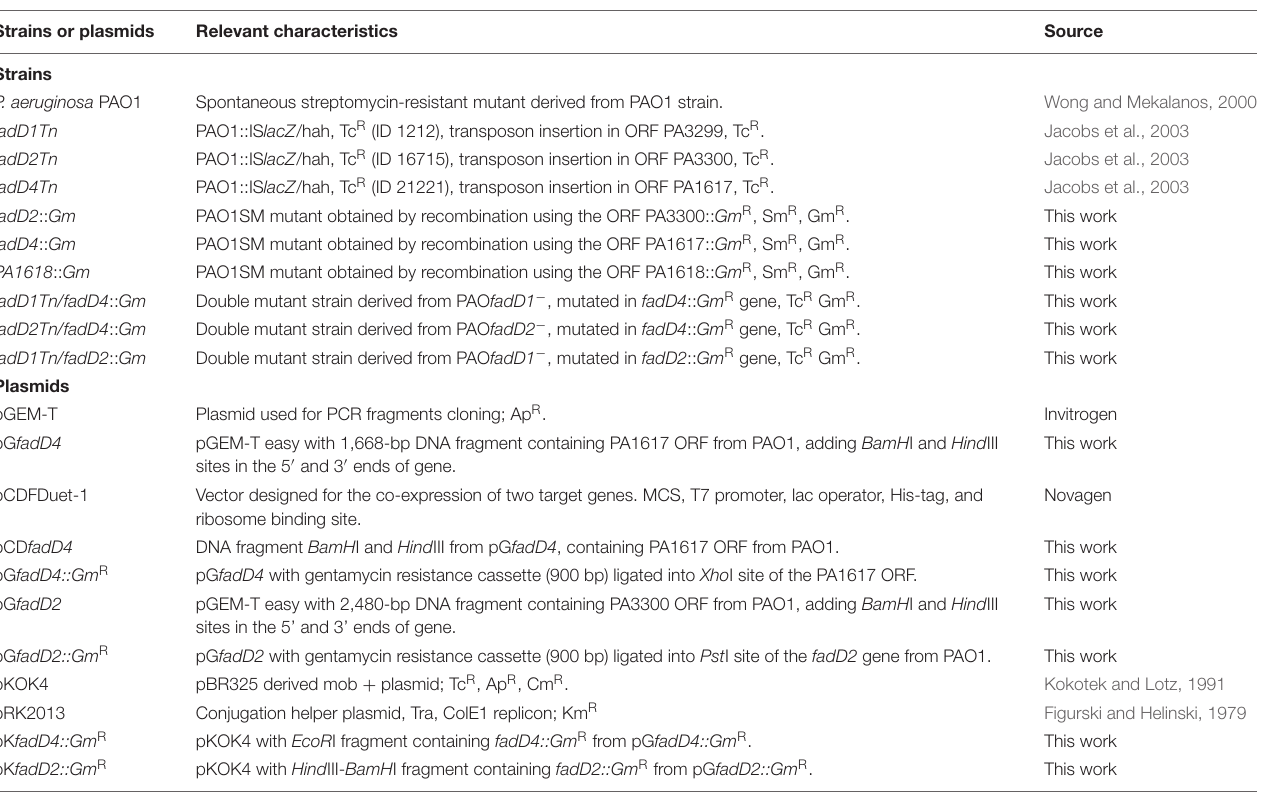
TABLE 1 | Strains and plasmids used in this work. Strains or plasmids Relevant characteristics Source